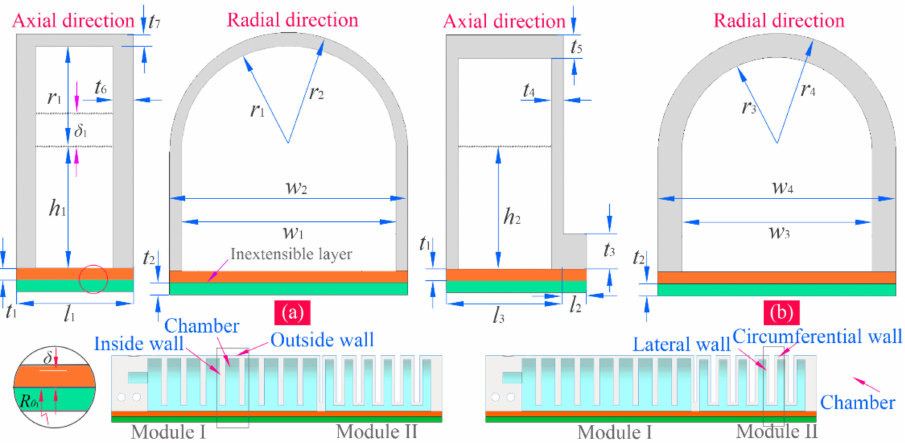
Figure 2. Cross-sections of the soft chambers: ( a ) chamber of module one and ( b ) chamber of module